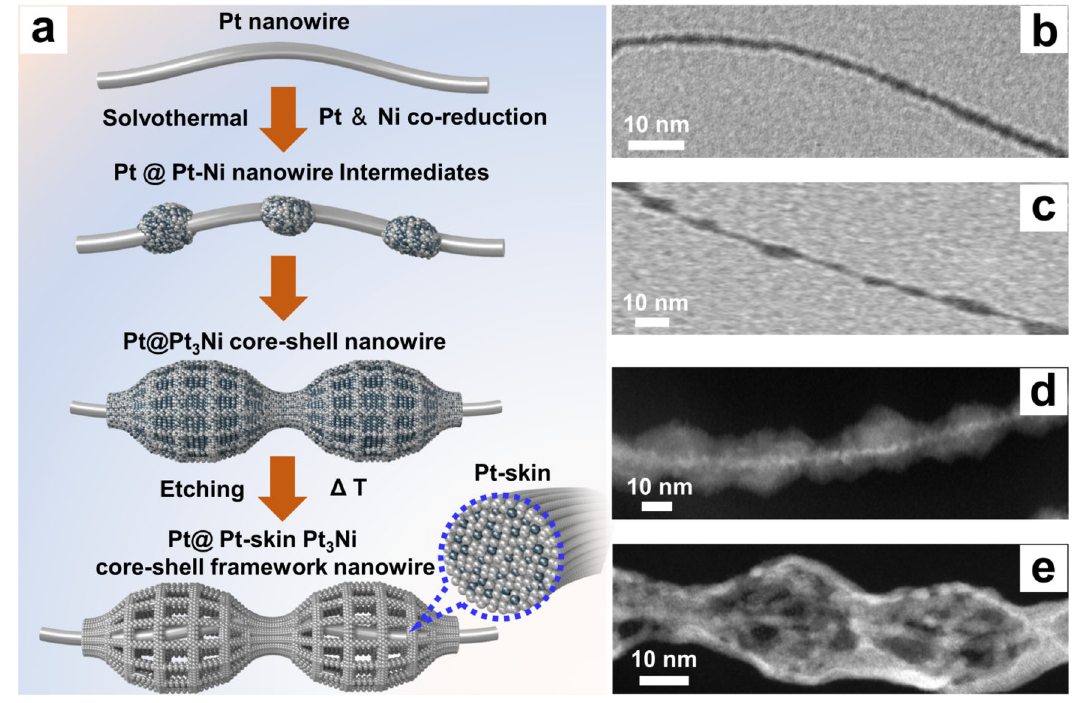
Fig. 1 | Illustration (left) and corresponding TEM images (right) of the samples obtained at four stages during the growth process from ultrathin atomic- jagged Pt nanowires to mesoporous Pt@Pt-skin Pt 3 Ni core-shell framework nanowires (CSFWs). a Schematic illustration of the preparatiom of mesoporous